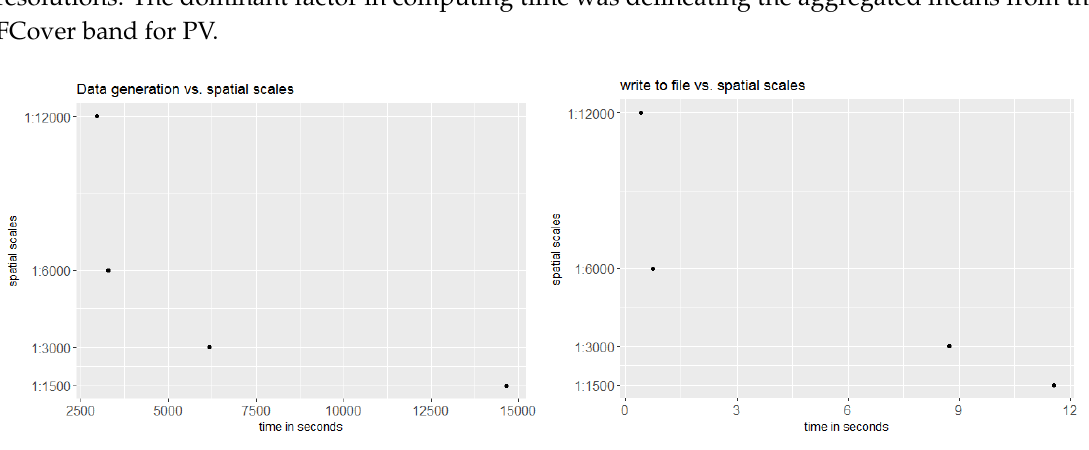
Figure 16. Comparative information about computational time on ( a ) the delineation of green vegetation out of FCover imagery and ( b ) writing to a csv file that will be used as an input file for BRT modelling.